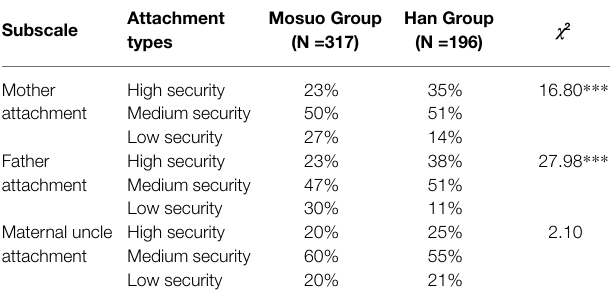
TABLE 2 | Ethnic differences in attachment types in Study 1.